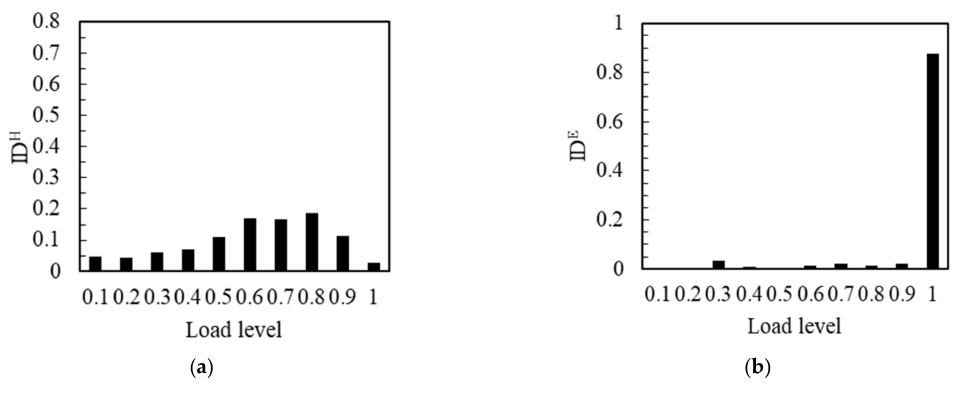
Figure 9. ID H and ID E of the No.6 notched beam: ( a ) ID H ; ( b ) ID E .